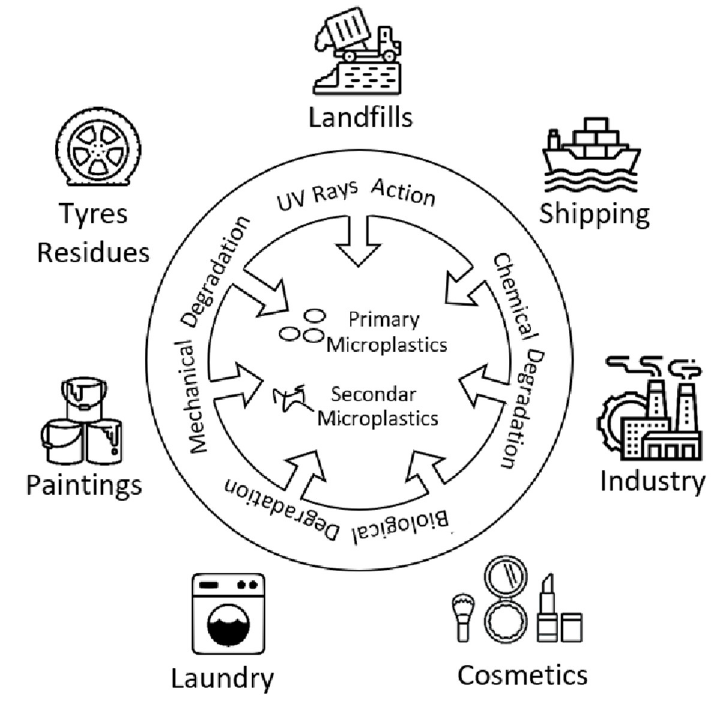
Figure 1. Microplastic sources and types.